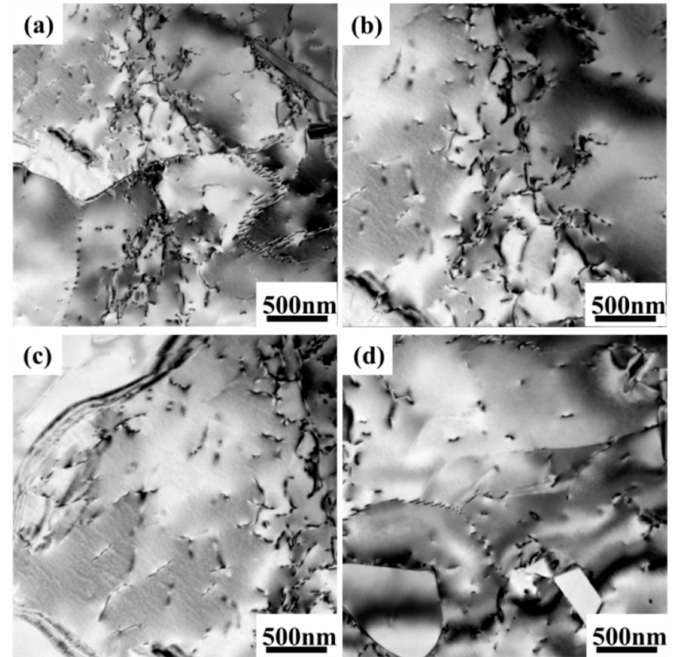
Figure 6. TEM images of aluminum alloy 5083 containing 0.05 wt.% V at di ff erent deformation temperatures: ( a ) 300 ◦ C, ( b ) 350 ◦ C, ( c ) 400 ◦ C, and ( d ) 450 ◦